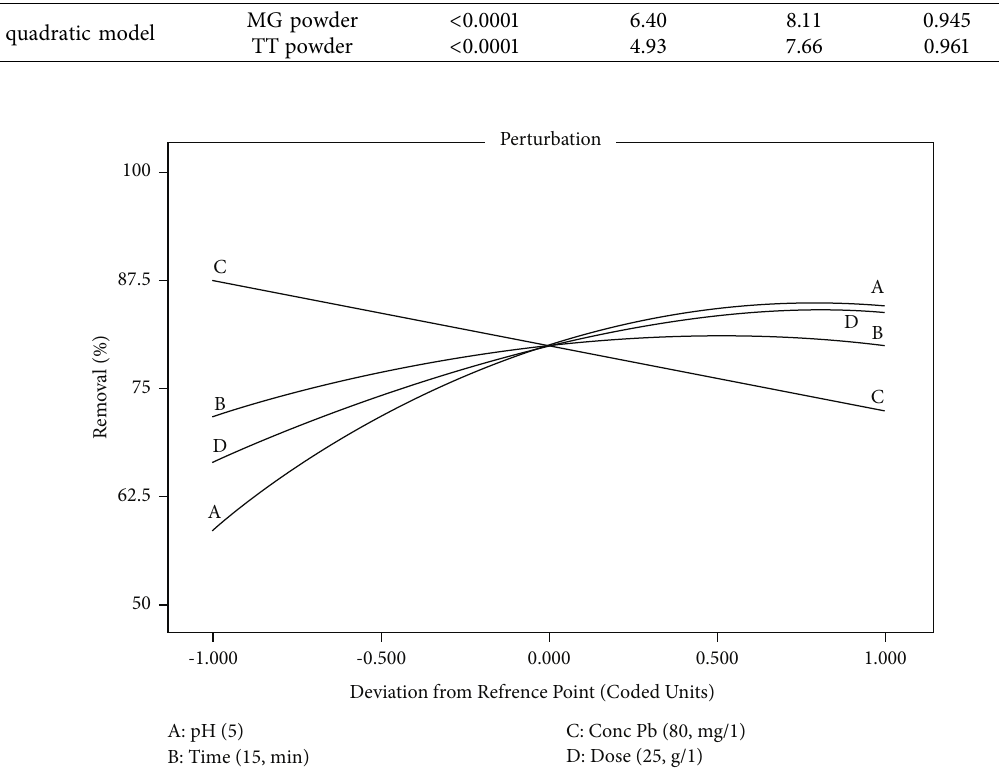
Figure 3: Parameters perturbation for MG